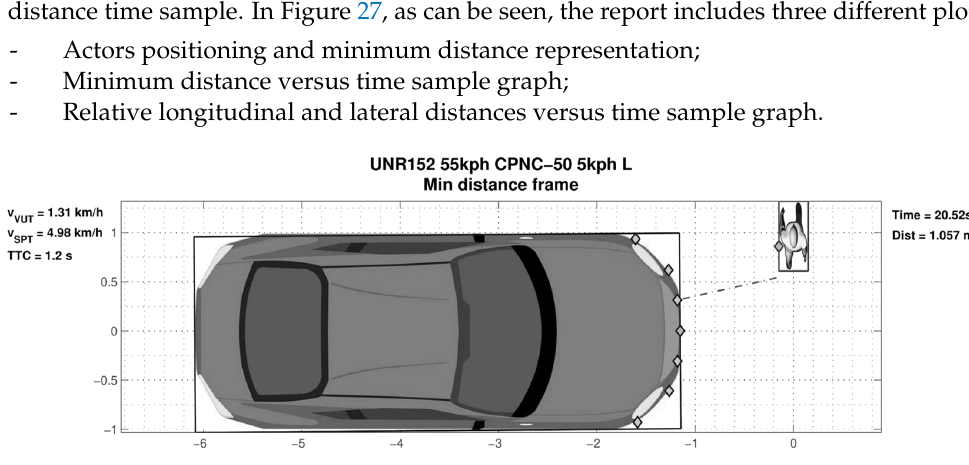
Figure 27. UNECE R152 CPNC 55 km/h PDF export: actors positioning and minimum distance rep- resentation; minimum distance versus time sample graph; relative longitudinal and lateral distances versus time sample graph. The result generated automatically by the proposed tool (Figure 27) allows us to ob- tain all the information of interest relating to the operation of the safety systems in the analyzed case; in particular, the TTC of 1.2 s makes it possible to manage the situation with awareness from an autonomous-driving point of view 4. Discussion The proposed algorithms included in a complete tool were designed to improve the ability to generate test maneuvers for Advanced Driver Assistance Systems (ADASs) and to automate the collection and analysis of data relating to tests for LSSs and AEB systems in compliance with Euro NCAP LSS 3.0.2 [8], Euro NCAP AEB C2C 3.0.2 [9], and UNECE CPNC [10]. The main purposes for which the algorithms were created are as follows: